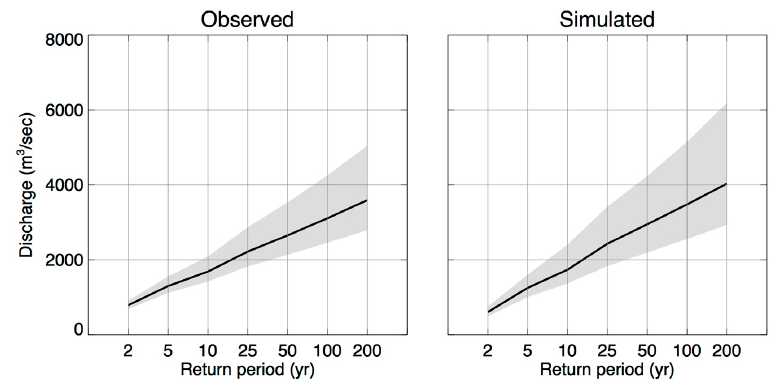
Figure 5. Comparison of flood frequency analysis using Peak FQ in the period 1960–2009, with the observed annual peak flows ( left panel ) and the median of the 19 simulated flood projections ( right panel ) in Cedar River at Cedar Rapids.